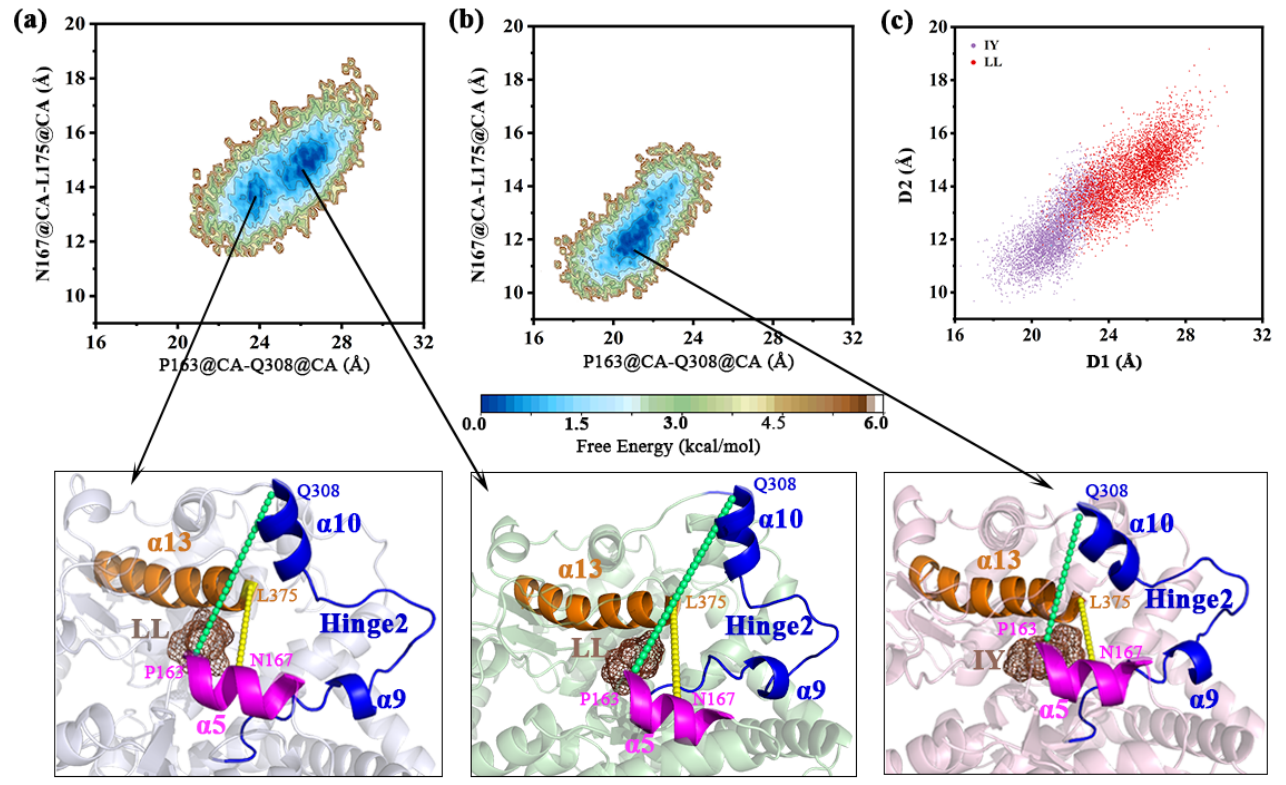
Figure 9. Free energy landscape showing the α 10-helix in–out for the complexes ( a ) ACE–LL and ( b ) ACE–IY, ACE–LL represents the complex system of protein and dipeptide Leu-Leu, ACE–IY stands for complex system of protein and dipeptide Ile-Tyr; ( c ) population density of the LL-bound and IY-bound ACE (angiotensin-converting enzyme), D1 was P163@CA-Q308@CA, and D2 was N167@CA-L175@CA. The respective global minimum structures for both structures are also shown below.